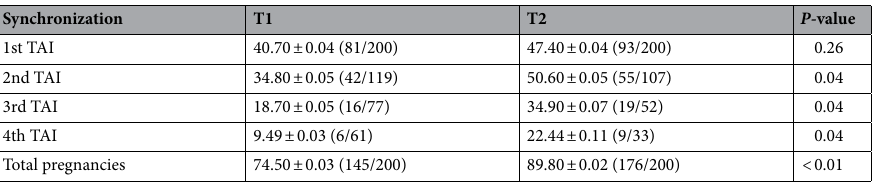
Table 1. Pregnancy per AI (LSM ± SE) of control treatment (T1, n = 200) and test treatment (T2, n = 200). Data in parentheses indicate the numbers of pregnant cows (numerator) and cows at risk